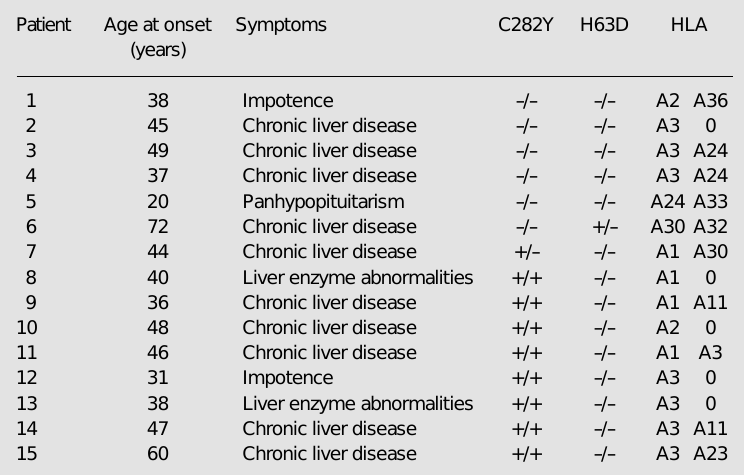
Table 2. Determination of HLA-A frequencies and C282Y and H63D mutations in Brazilian patients with